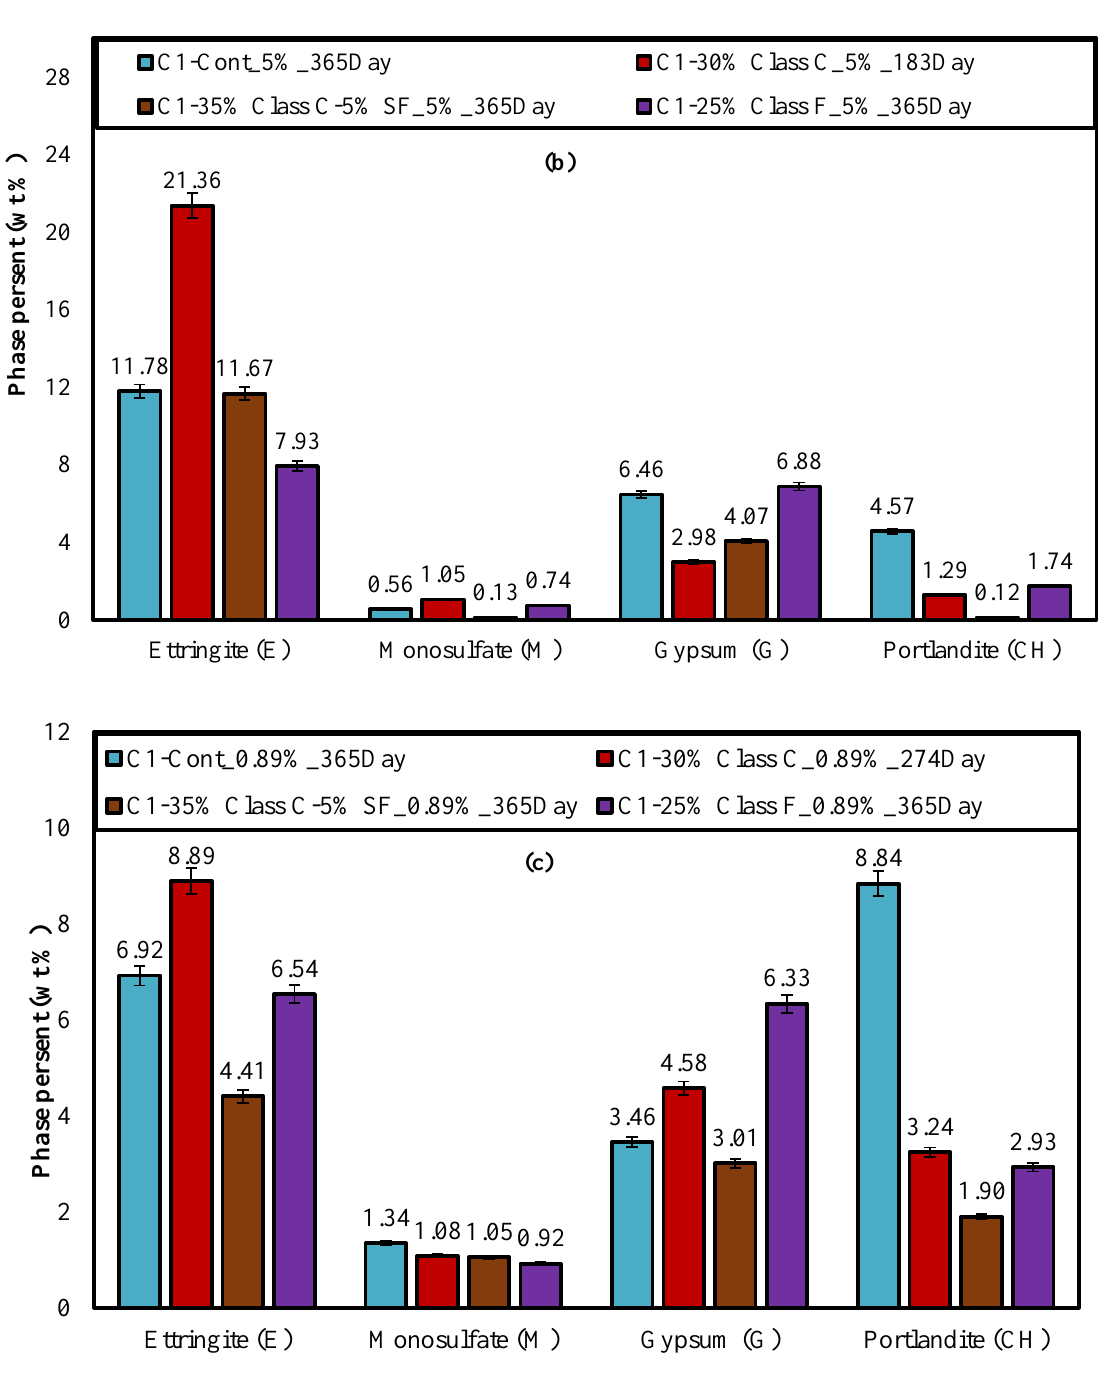
Figure 11. ( a ): Rietveld results for mortars using cement C1 submerged in 5% Na2SO4 after 56 days, ( b ): Rietveld results for mortars using cement C1 submerged in 5% Na 2 SO 4 after 1 yr, ( c ): Rietveld results for mortars using cement C1 submerged in 0.89% Na 2 SO 4 after 1yr.